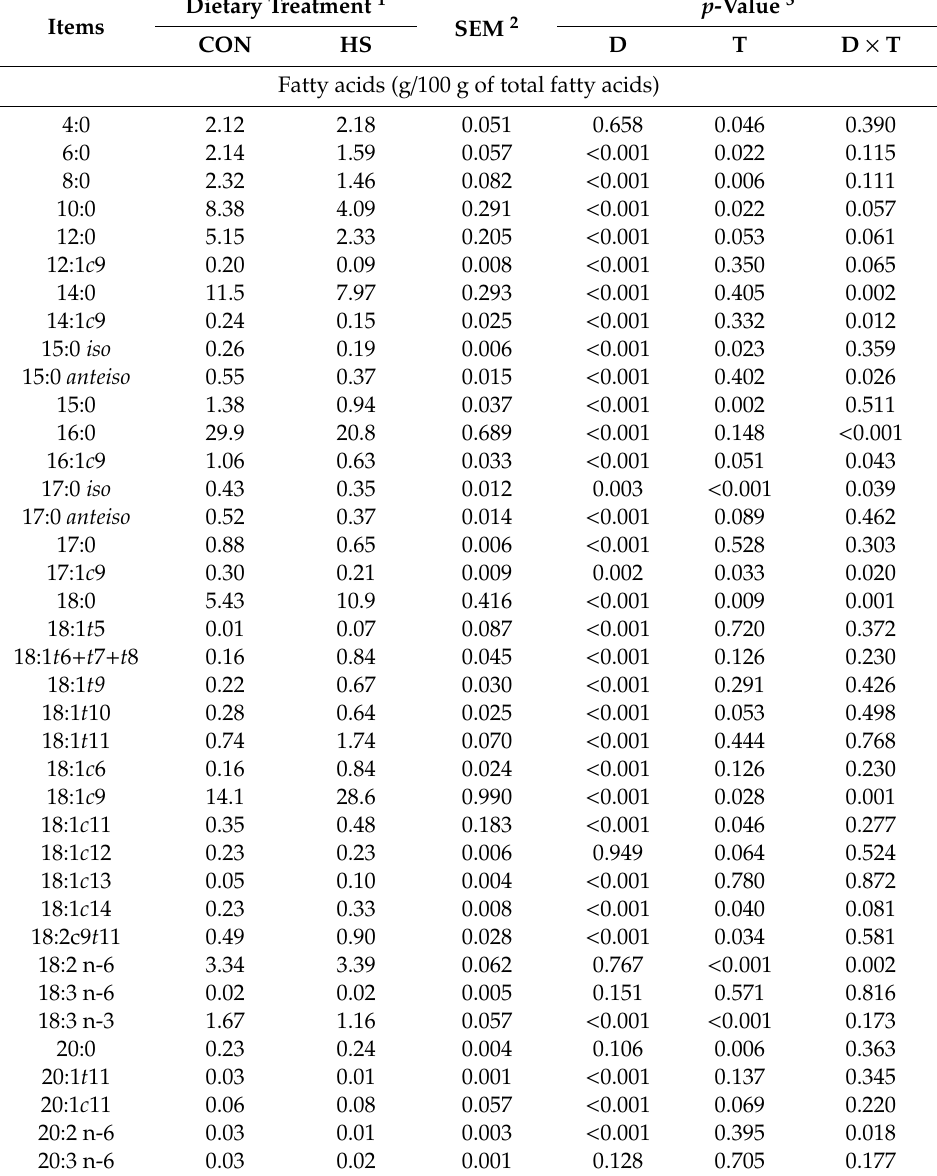
Table 4. The e ff ect of the dietary treatment on milk fatty acids (g / 100 g of total fatty acids). Dietary Treatment 1 Items SEM